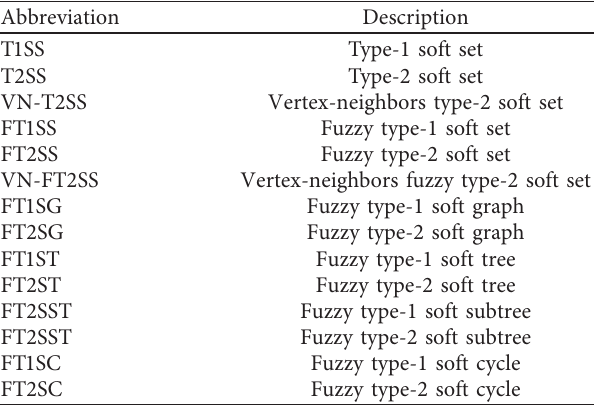
Table 1: List of